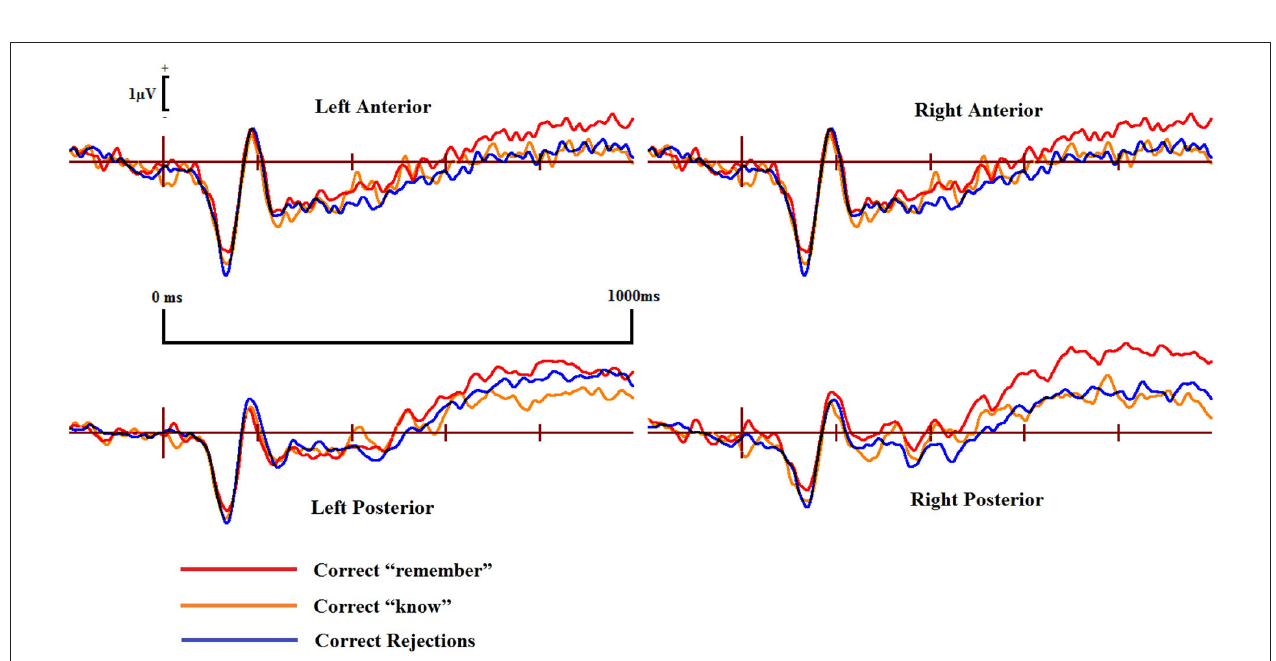
FIGURE 6 | ERPs of correct “remember” and “know” responses compared to correct rejections from the four scalp locations for the DP cases .